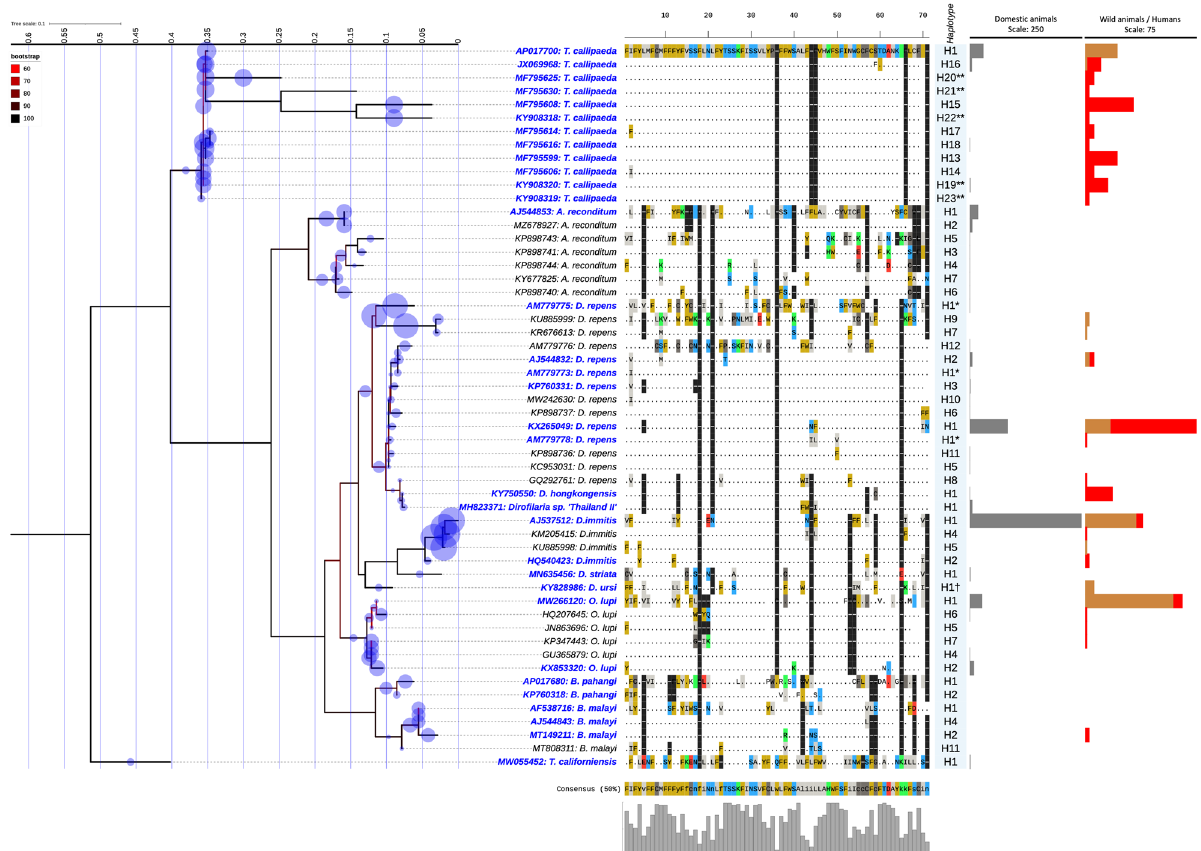
Figure 2. ML phylogeny showing the distribution of the haplotypes of zoonotic VBHs of canids delineated by the 12S rRNA distance clustering. The tree corresponds to the IQTREE inferred from 54 partial (413 bp) DNA sequences with 48.9% of informative sites using the TIM2 (+F+R4) model under 1000 bootstrap replicates and ML method. Branch are color-coded according to the bootstrap value. Species name and GenBank accession number are indicated at the tip of each branch. Bold blue label indicated the reference sequences used in the MLST phylogeny. The tree includes 226 query sequences from the zoonotic VBHs of canids (blue circle) placed at the branch and leaf nodes by the EPA-ng algorithm. The MY_SCHEME_1 sequence alignment viewer of the informative sites from the amino acid alignment and their 50% consensus are shown. The amino acid sequences of the haplotype 1 from each species were used as reference sequence to dot repeats in amino acids throughout the whole haplotypes of the species. Haplotype names are indicated for each node label. Number of domestic, wild, and human infection cases with each haplotype are shown by the bar charts at each node. * and ** indicate delineation failure of the cox 1 and 12S distance clustering respectively. † Indicates inconsistency between the morphological taxonomy and the present molecular